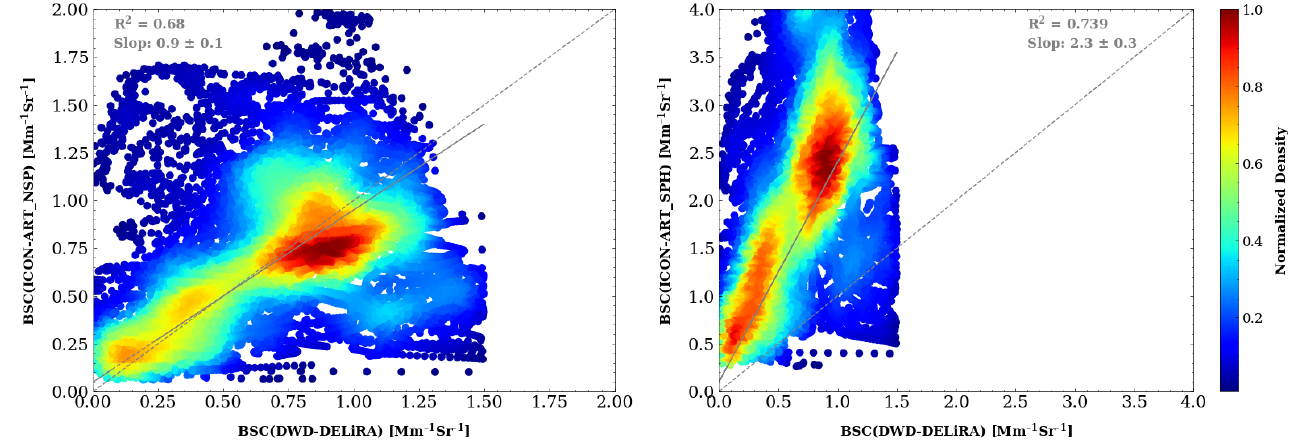
Figure 11. Correlation of Saharan dust backscatter coefficients measured by LiDAR and simulated by ICON-ART for both spherical and non-spherical parameters. SPH = spherical; NSP =